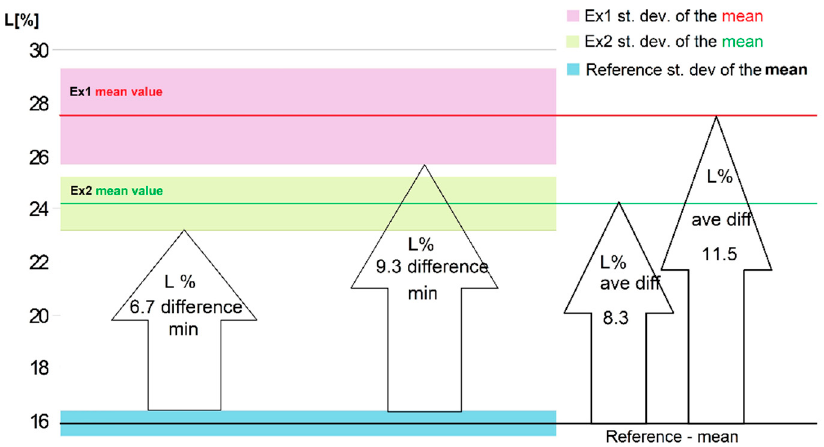
Figure 5. Measurements of elongation—the mean values and the error found in each experiment. The arrows show the minimum differences between elongation with and without treatment (differ- ence min) or the difference between the mean values (average difference).